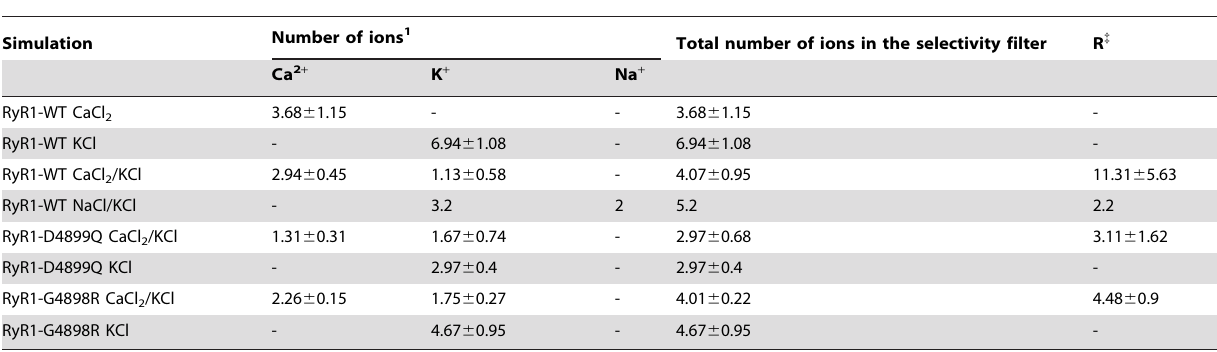
1 In the selectivity filter, which is the shaded region shown in Figure 4 and Figure 5. { Ratio of preferential occupancy of ion1 over ion2 normalized by total number of ions present in each